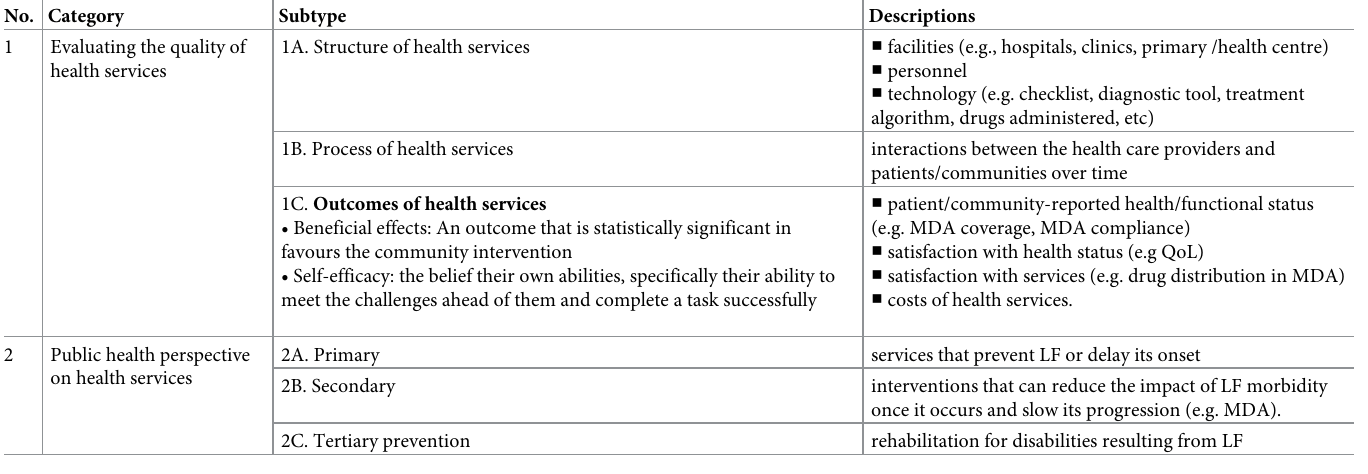
Table 2. Description of health services research in this review.